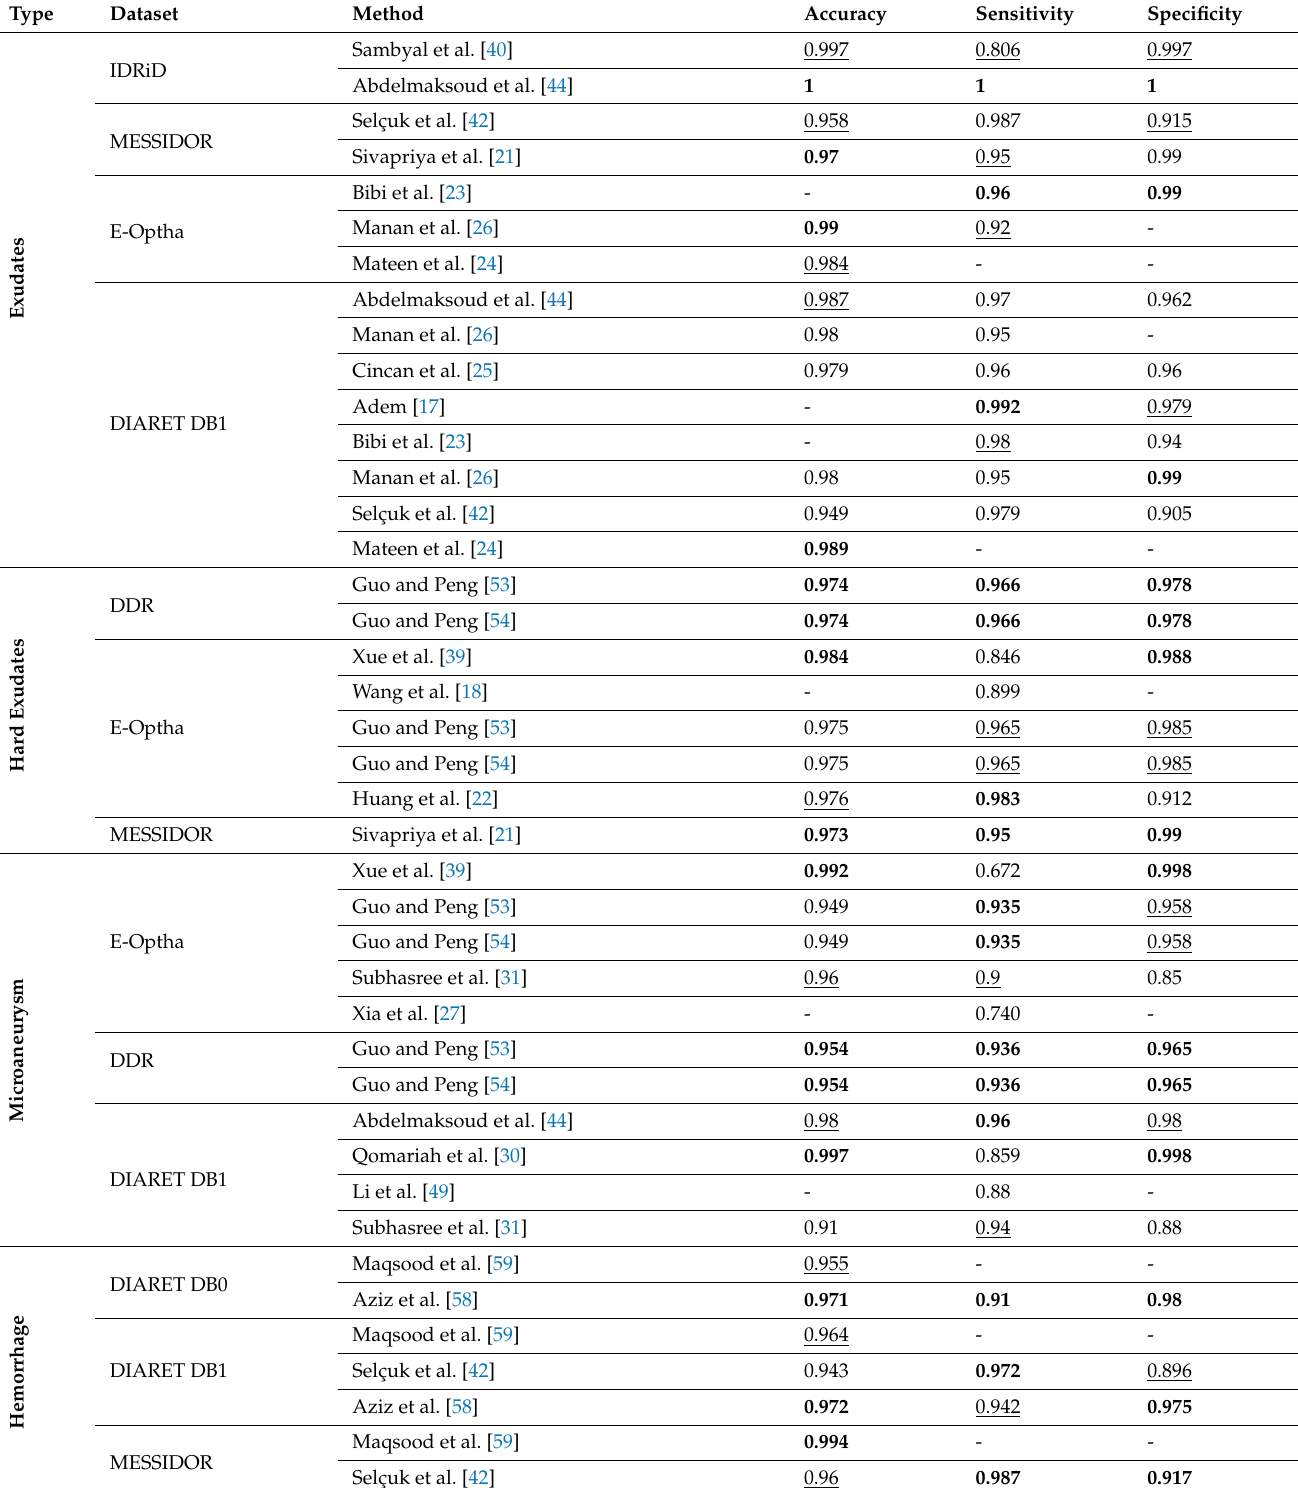
Table 6. Performance comparison of deep-learning based diabetic retinopathy lesion-detection. The bold and underlined fonts correspondingly show the first and second